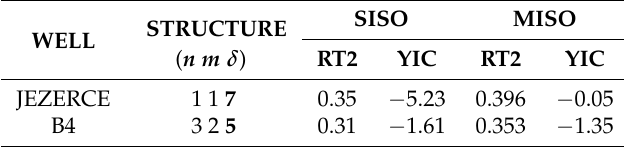
Table 2. Model structure and values of the identification factors.